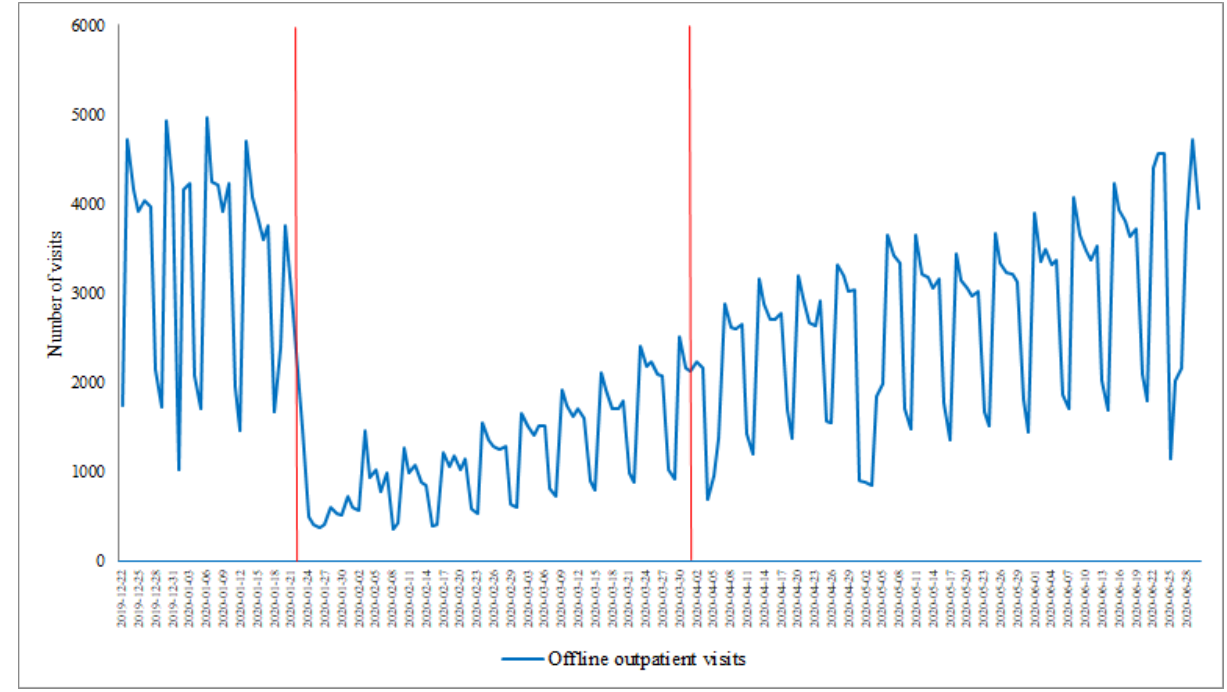
Figure 5. The trends of hospital outpatient visits from December 22, 2019, to June 30, 2020. The red lines denote the start of the controlled period and the end of the postepidemic period.